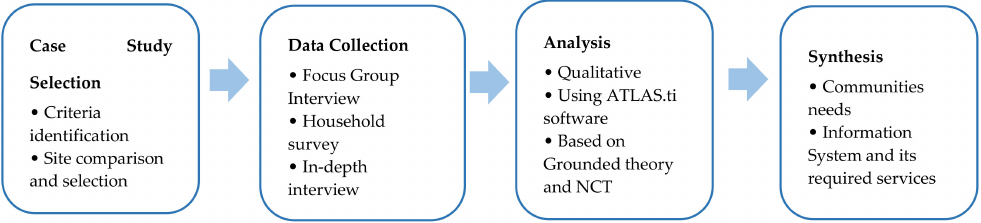
Figure 1. Overview of research